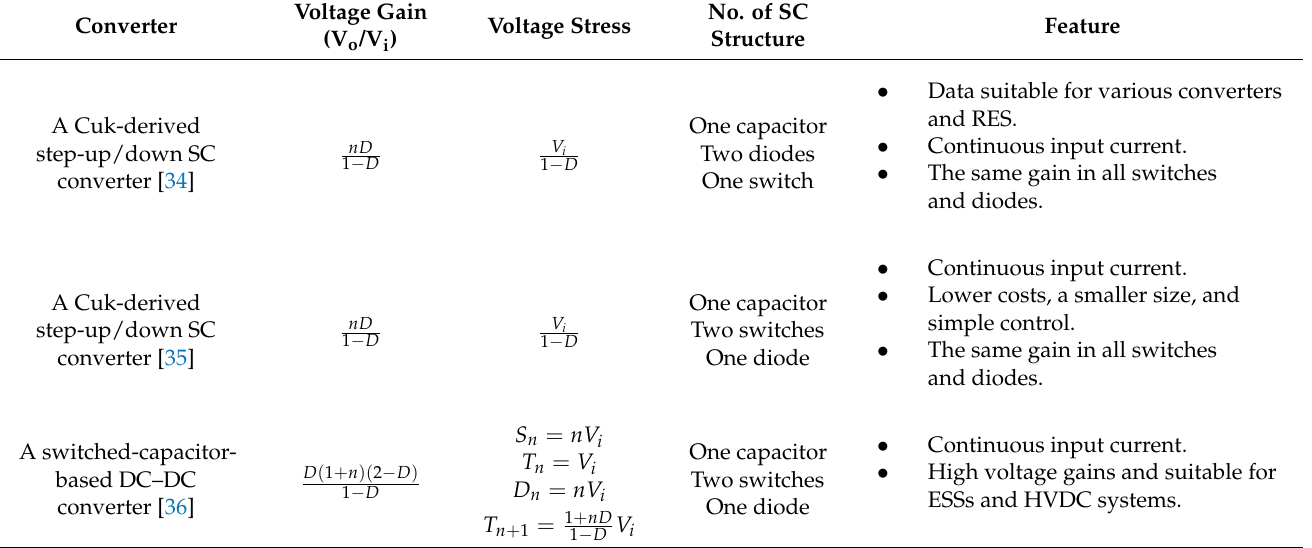
Table 3. Review of different step-up/down SC converters in the review.